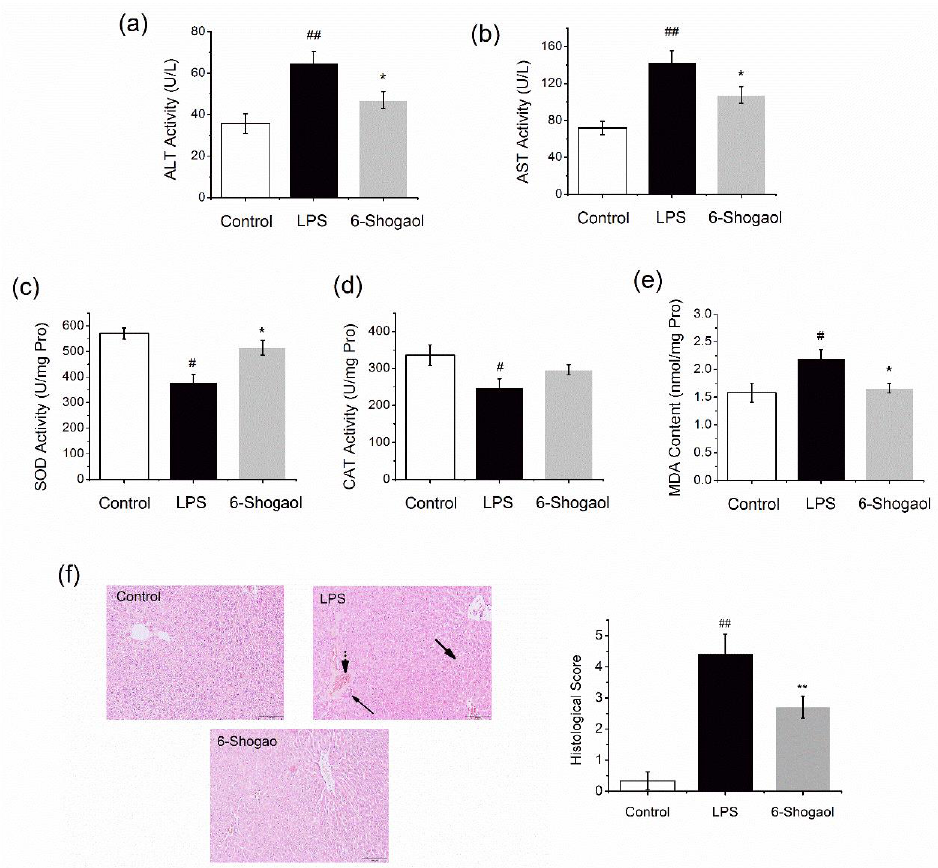
Figure 1. 6-Shogaol improved hepatic function and oxidative stress in mice. ICR mice received daily oral administrations of 6-shogaol (20 mg/kg) for 7 consecutive days. The control and LPS groups were administered with the vehicle. On day 8, mice in LPS and 6-shogaol groups received an i.p. injection of LPS (10 mg/kg). After 24 h, the mice were sacrificed: ( a ) serum ALT activity; ( b ) serum AST activity; ( c ) hepatic SOD activity; ( d ) hepatic CAT activity; ( e ) hepatic MDA level; ( f ) histolog- ical examination of liver tissues by HE staining. LPS group showed lymphocytic infiltration (arrow), hydropic degeneration (thick arrow), and congested blood vessels (arrow with dot tail). Data are presented as mean ± SEM (n = 8). # p < 0.05, ## p < 0.01 versus control group; * p < 0.05 versus LPS group, ** p < 0.01 versus LPS group. LPS, lipopolysaccharide; ALT, alanine aminotransferase; AST, aspartate aminotransferase; SOD, superoxide dismutase; CAT, catalase; MDA, malondialdehyde. 3.2. 6-Shogaol Suppressed MAPK/NFκB Pathway in the Liver Activation of MAPK/NFκB is crucial for inflammatory response. Therefore, we next evaluated the protein expression of JNK, ERK, IkBα , and NFκB p65 (Figure 2). LPS acti- vated MAPK by significantly elevating the phosphorylation of JNK and ERK, thereby caused d egradation of IκBα and triggered the phosphorylation of p65 ( p < 0.01). All these changes were markedly reversed by treatment with 6-shogaol ( p < 0.05 and p < 0.01). These results indicate that 6- shogaol regulated hepatic inflammation through MAPK/NFκB pathway.